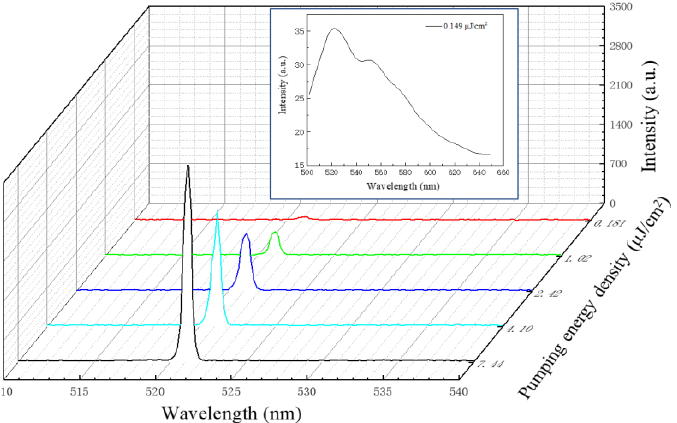
Figure 7. Output from octagonal quasicrystal defect-mode laser-based PVK: Ir(ppy) 3 complex at different pumping energy density. (The different color line represent different pumping energy den- sities.)